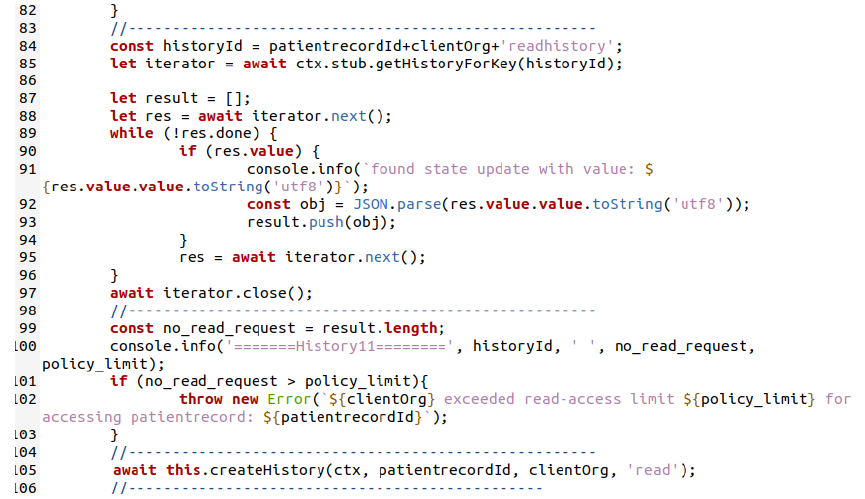
Figure 14. Smart-contract code using Node.js.